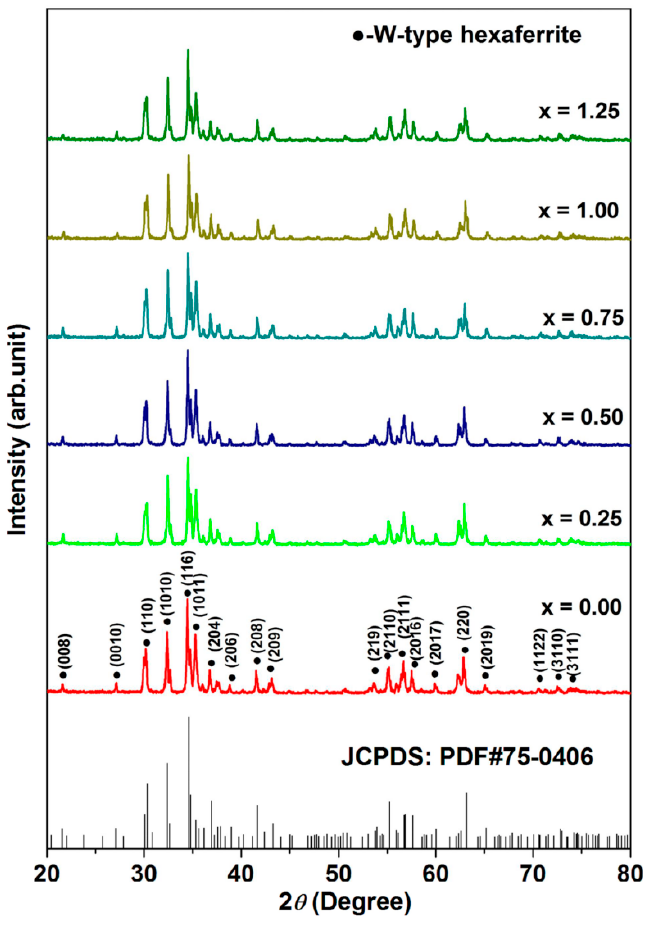
Figure1showstheXRDpatternsoftheW-typeSrYbhexaferriteSr 0.85 Yb 0.15 Zn 1.5 Co 0.5 Al x Fe 16 − x O 27 (0.00 ≤ x ≤ 1.25). As shown in Figure 1, the XRD patterns confirmed that all the samples had